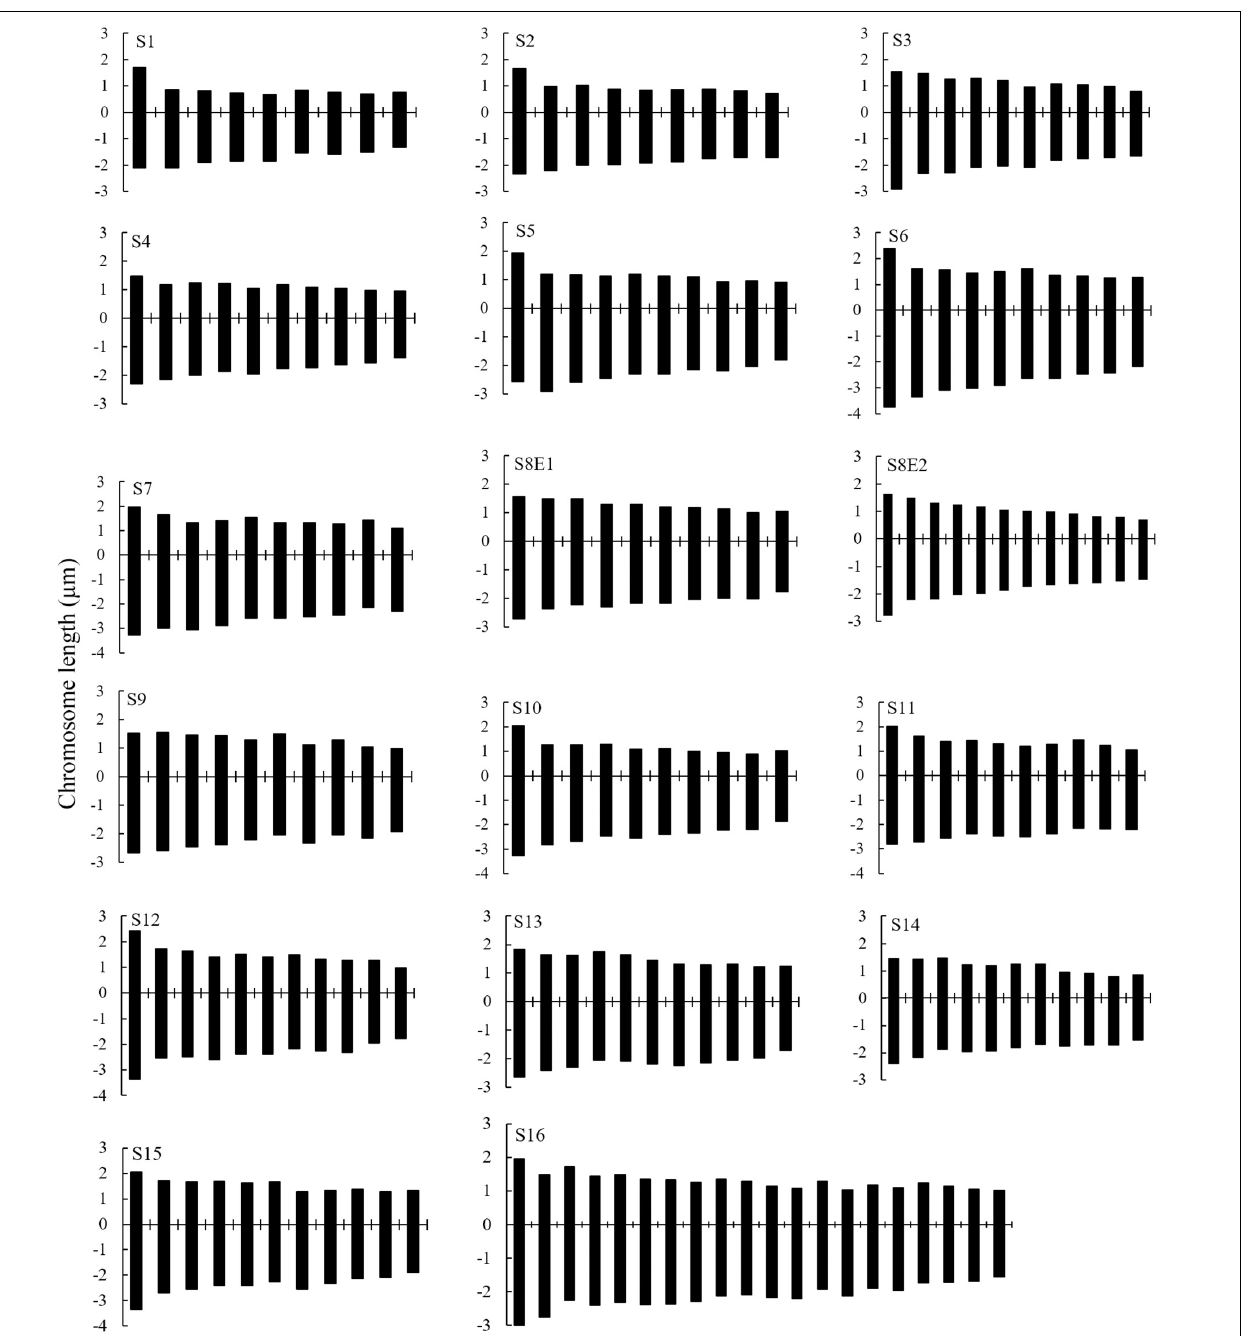
FIGURE 3 | Haploid chromosome ideograms of 17 Pimpinella populations of 16 species. S1 ( P. affinis , 2m + 7sm), S2 ( P. eriocarpa , 1m + 8sm), S3 ( P. tragium , 5m + 5sm), S4 ( P. saxifrage , 8m + 2sm), S5 ( P. aurea , 1m + 9sm), S6 ( P. tragioides , 2m + 8sm), S7 ( P. olivieri , 3m + 7sm), S8 ( P. khayyamii , E1: 4m + 6sm; E2: 4m + 8sm), S9 ( P. kotschyana , 5m + 5sm), S10 ( P. deverroides , 1m + 9sm), S11 ( P. olivierioides , 4m + 6sm), S12 ( P. anthriscoides , 8m + 3sm), S13 ( P. anisactis , 11m), S14 ( P. peucedanifolia , 7m + 4sm), S15 ( P. khorasanica , 9m + 2sm), and S16 ( P. rhodantha , 12m +